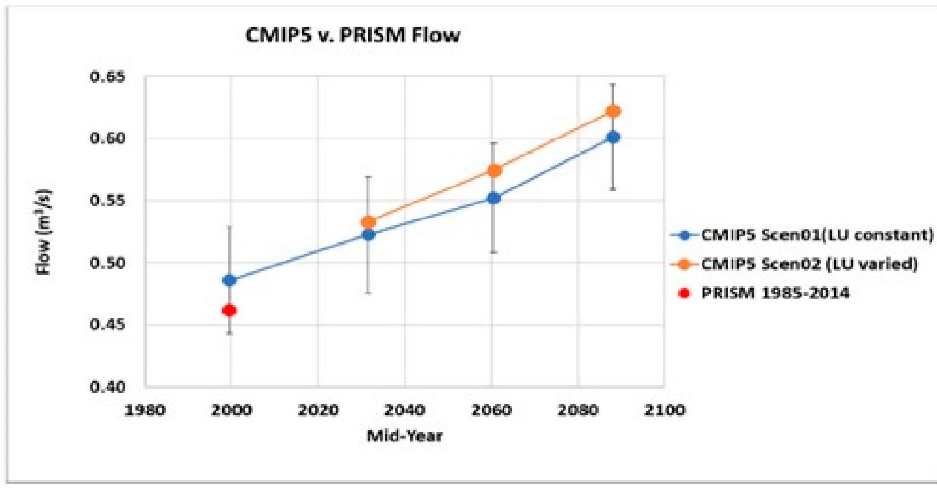
Figure 4. PRISM vs. average of 20 CMIP5 GCMs flow (2018–2100).